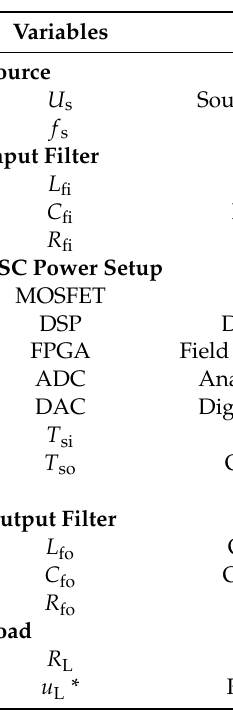
Figure 4. Picture of the experimental setup. 232 Table 2. Parameters of the SiC-MOSFET-based experimental